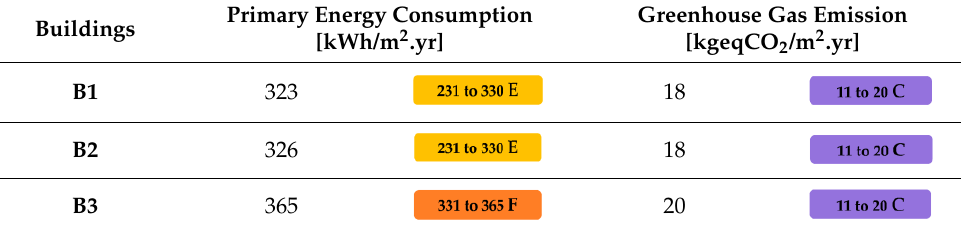
Table 2. Overall heat coefficients 𝐻 .